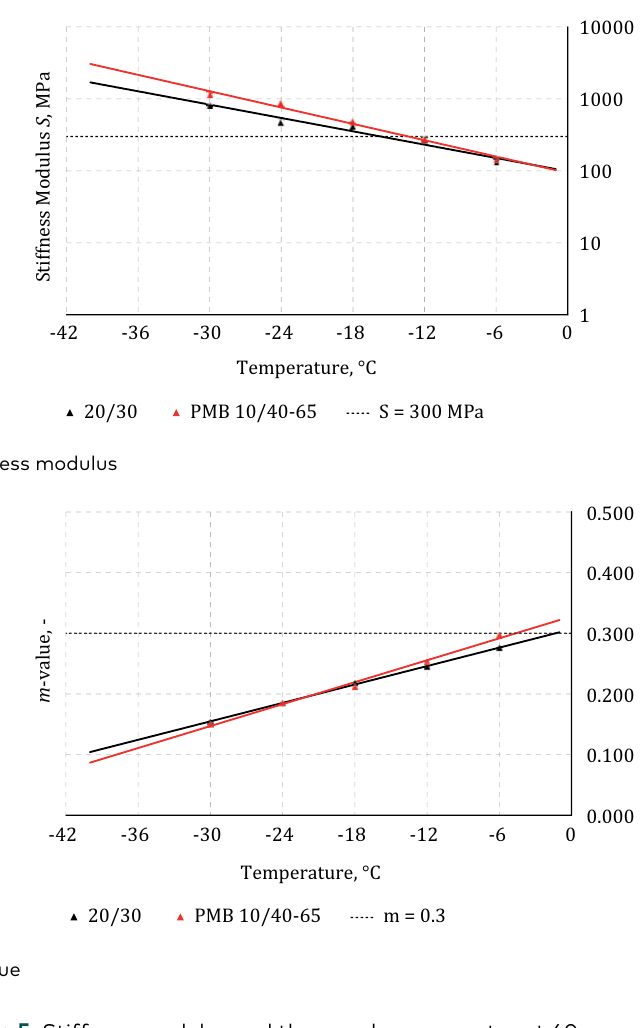
Figure 5. Stiffness modulus and the m -value parameter at 60 seconds loading from the Bending Beam Rheometer test versus temperature for hard consistency